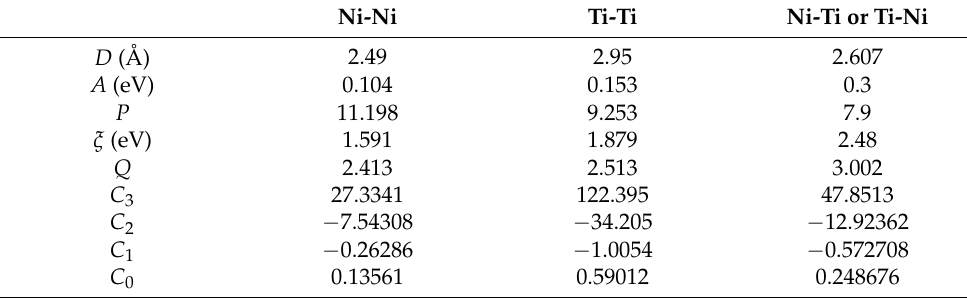
Table 2. Potential function